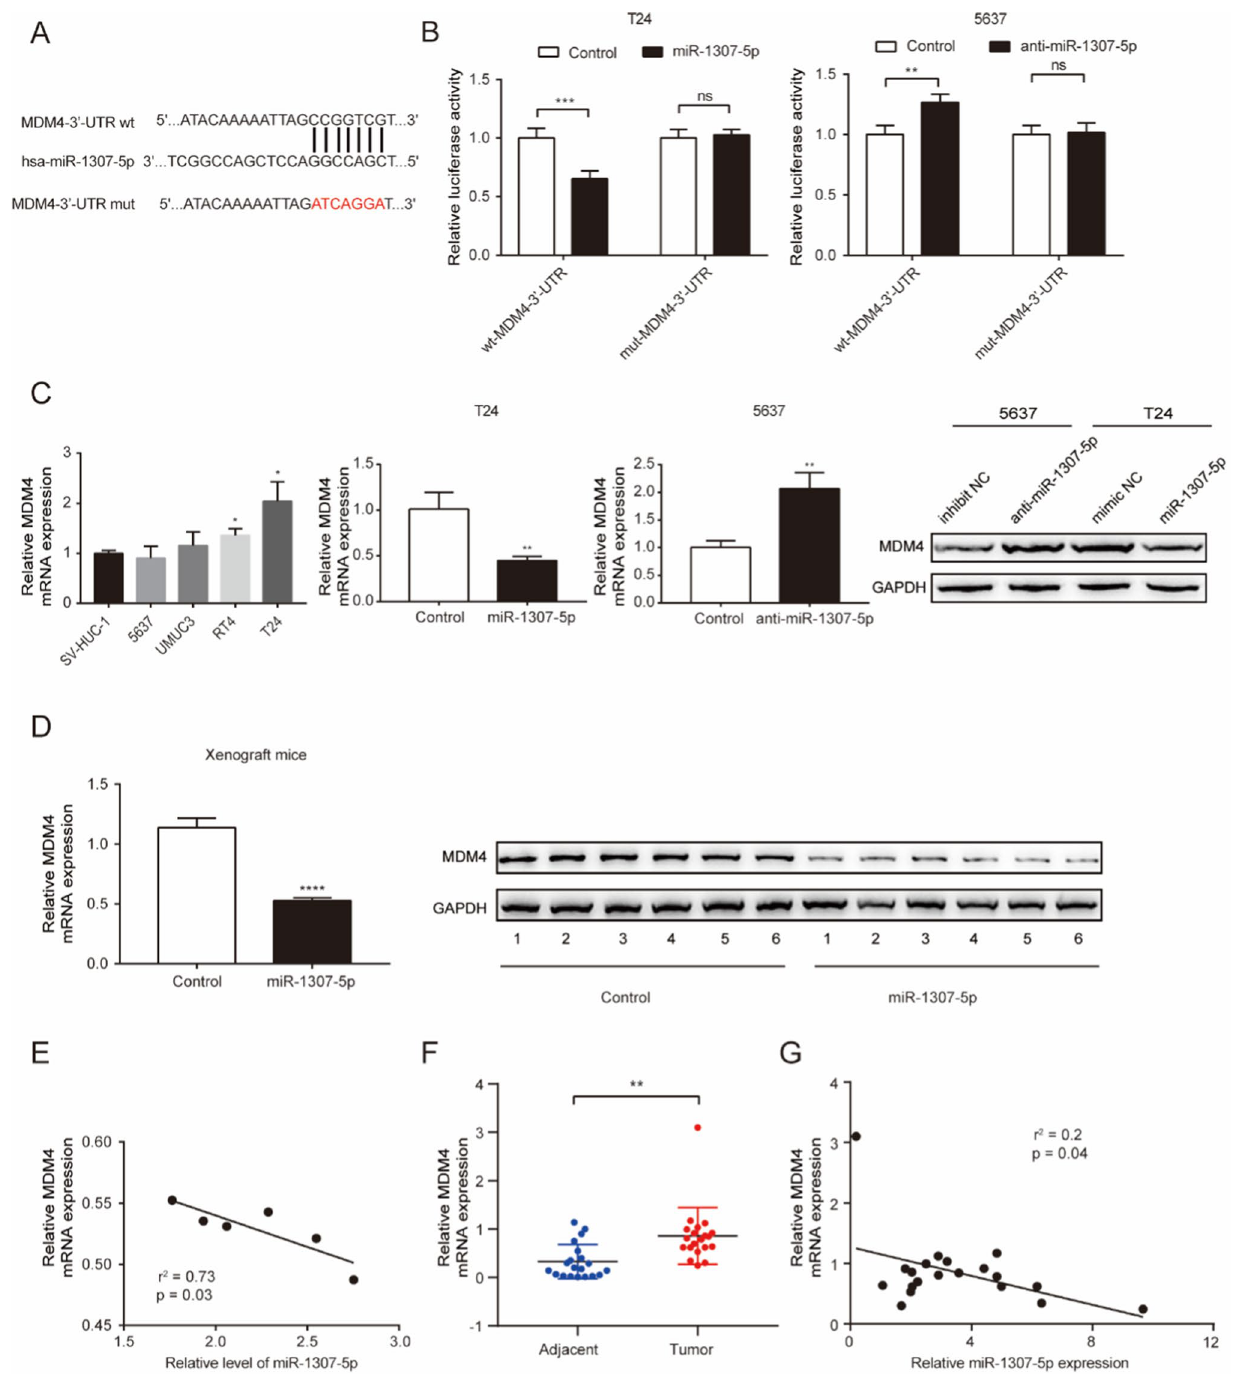
Fig. 4 MDM4 is a direct target of miR-1307-5p in bladder cancer cells. A Diagrams showing the putative miR-1307-5p binding site of MDM4 locus and corresponding mutant sites. B miR-1307-5p effects on luciferase reporters based on wild-type (wt) MDM4 3 ′ -UTR versus mutant (mt) 3 ′ -UTR. C T24 and 5637 cells that were transfected with corresponding miRNA vectors were subjected to RT–qPCR and western blot- ting for MDM4 expression. D RT–qPCR and western blotting analyses to compare MDM4 expression in xenografts. E An inverse correlation between miR-1307-5p and MDM4 mRNA expression in vivo. F RT–qPCR analysis of MDM4 in tumor tissues and matched normal tissues. G Inverse correlation between miR-1307-5p and MDM4 expression in -Spearman’s rank correlation analysis. **p < 0.01; ****p < 0.0001; ns, no significance. Data depicts the mean ± standard deviation and are representative of three independent